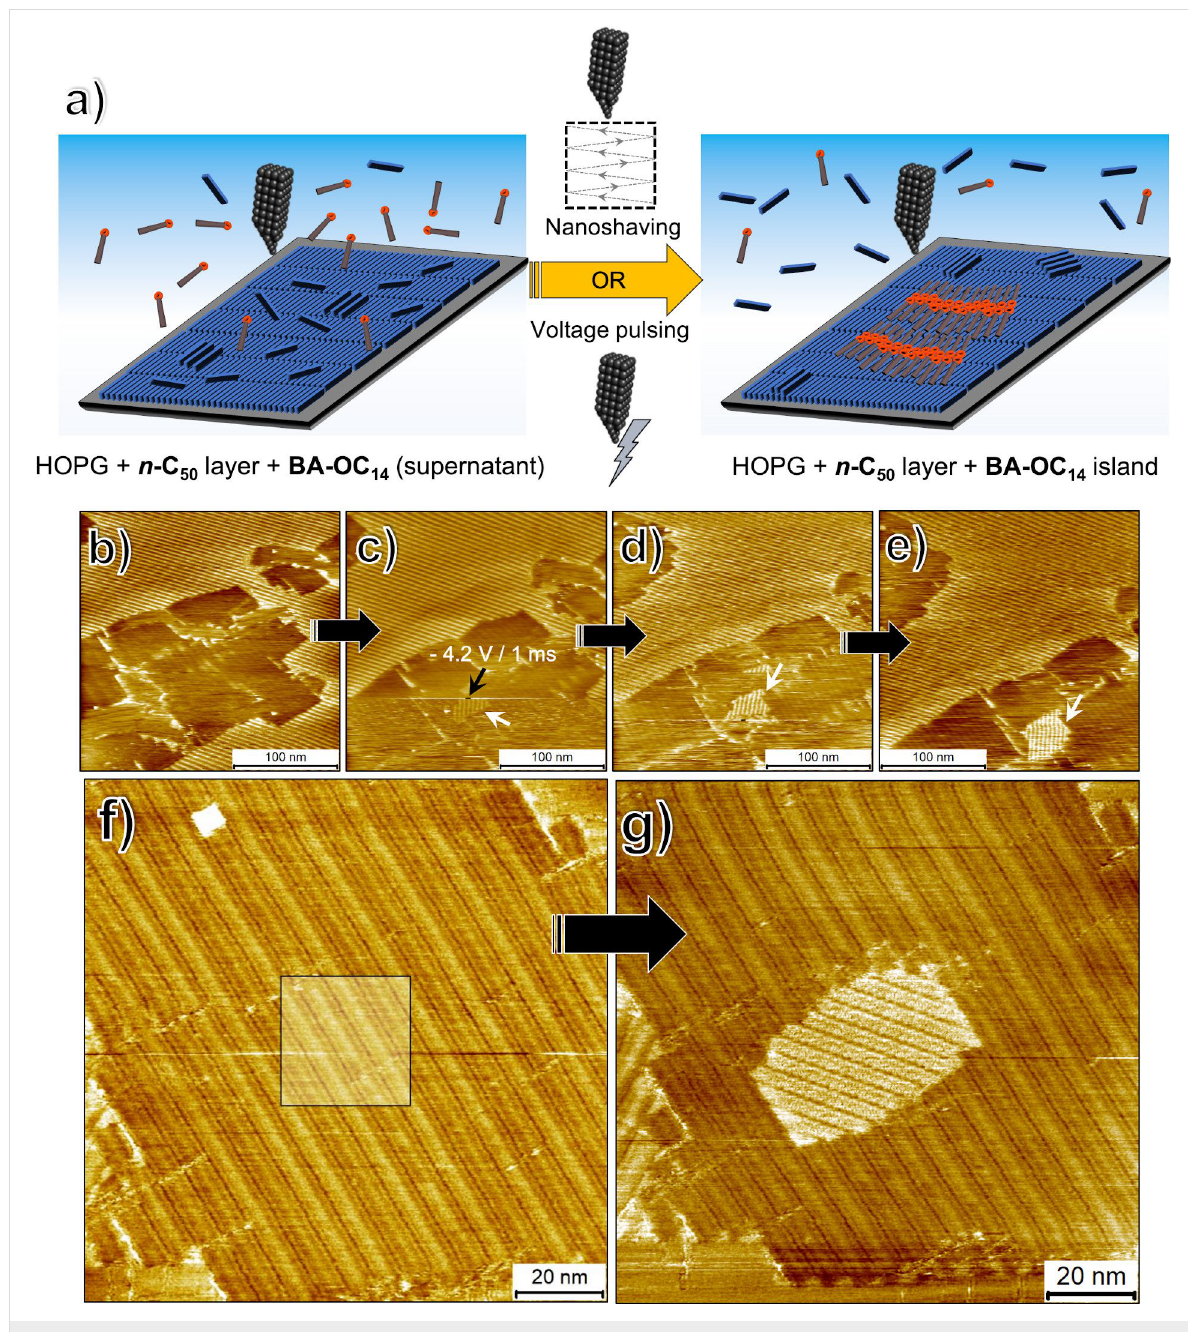
Figure 6: On-command nucleation of BA-OC 14 islands on top of the n -C 50 buffer layer. (a) Schematic for the STM-induced nucleation process. (b–e) Sequential STM images where the nucleation of BA-OC 14 islands was achieved using application of voltage pulses to the STM tip. The black arrow in (c) shows the point at which a − 4.2 V (1 ms) pulse was applied to the STM tip. The white arrow shows the island of BA-OC 14 that nucleated immediately after the pulse. As evident in panels (d,e) this island grew in subsequent scans. (f,g) Sequential STM images showing nucleation on-command by bringing the STM tip closer to the surface and scanning at high tunneling current. The square highlighted in (f) was scanned at − 0.05 V and 0.5 nA. After this, the original image size was restored by zooming out. As evident from (g) a new island of BA-OC 14 is nucleated approx- imately in the area which was manipulated in the previous scan. Imaging conditions: (b–e) I set = 130 pA, V bias = − 1.3 V; (f,g) I set = 140 pA, V bias = − 0.7 V.